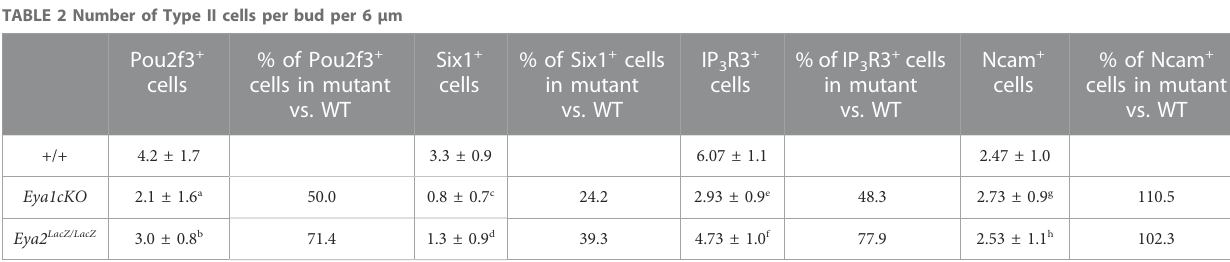
TABLE 2 Number of Type II cells per bud per 6 μ